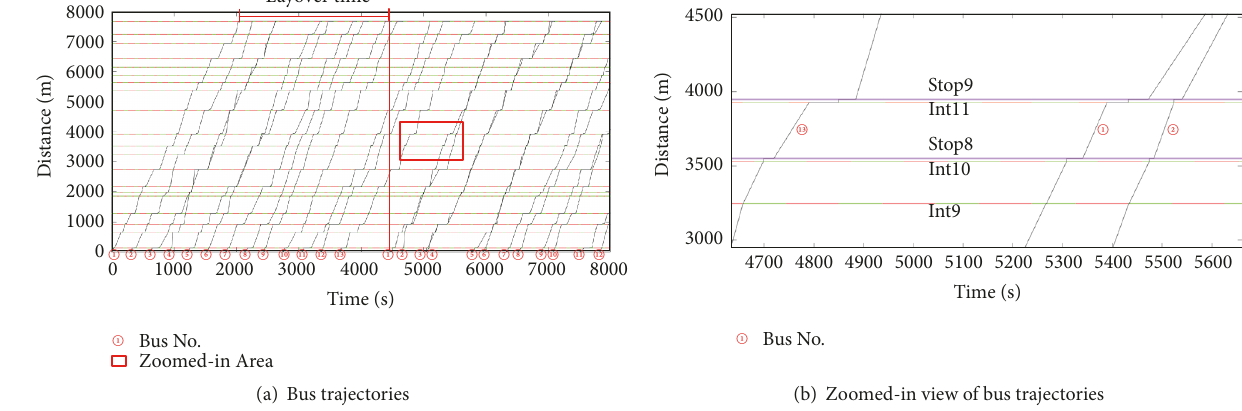
Figure 4: Illustration of the simulation